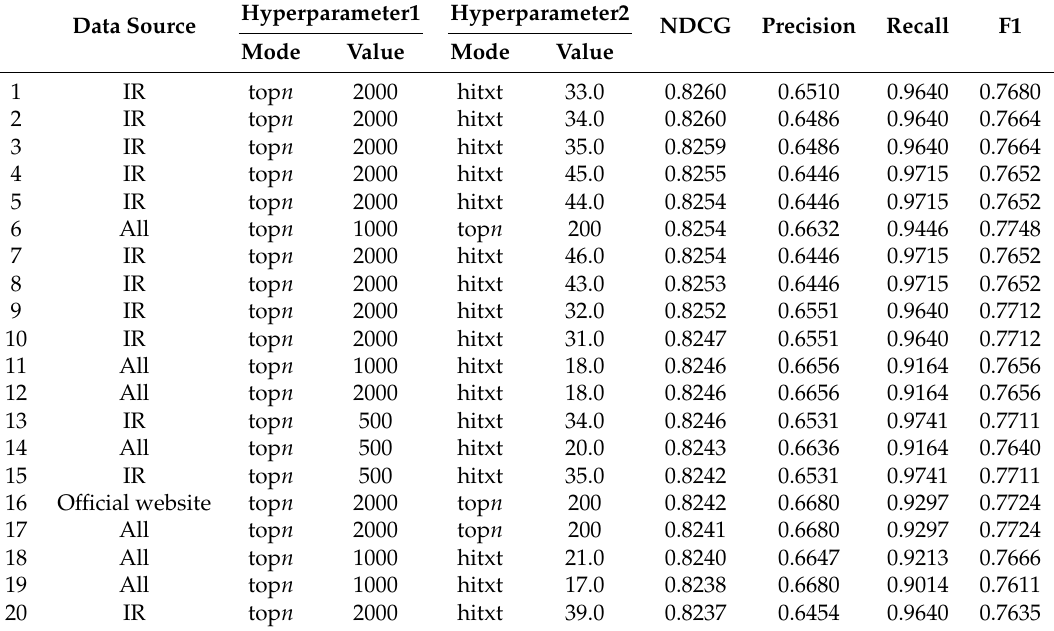
Table 8. Hyperparameter-tuning results based on normalized discounted cumulative gain